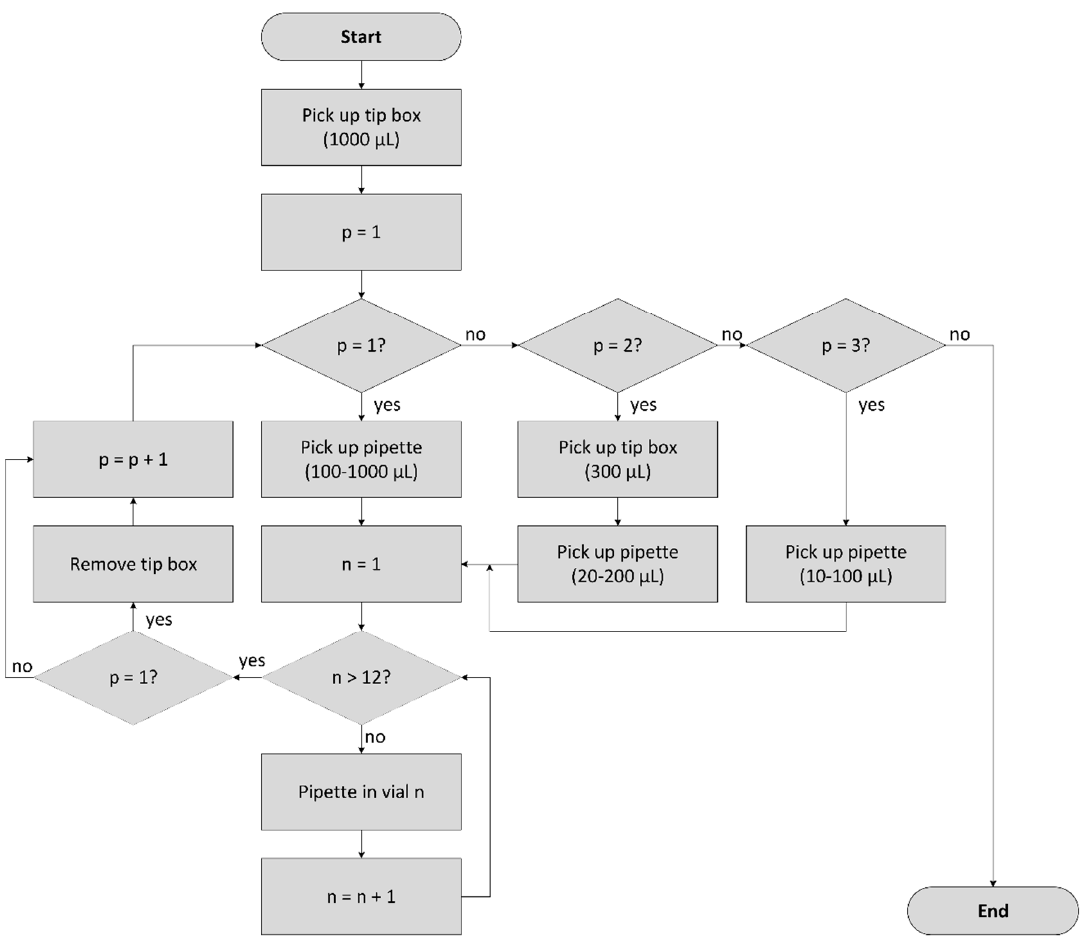
Figure 15. Process workflow of pipetting a volume of 1300 µ L using three manual pipettes in three pipetting steps.